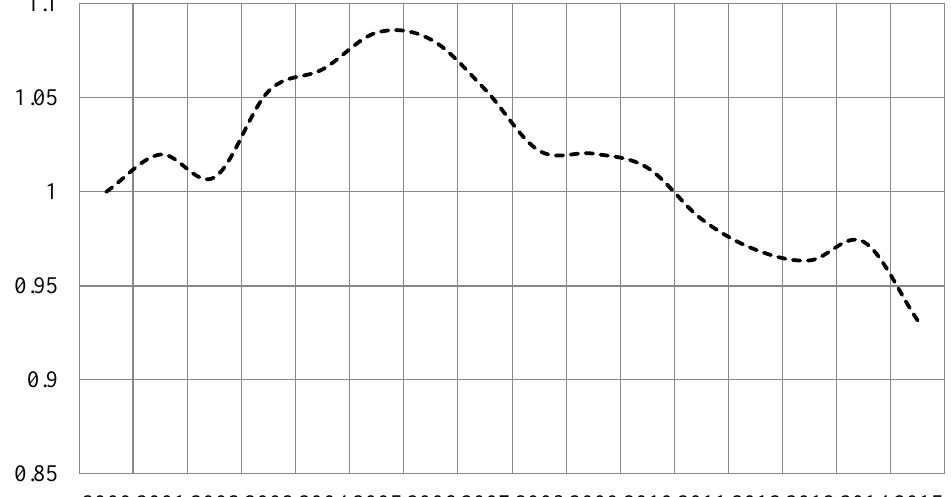
Figure 5: Energy Intensity of the Balearic